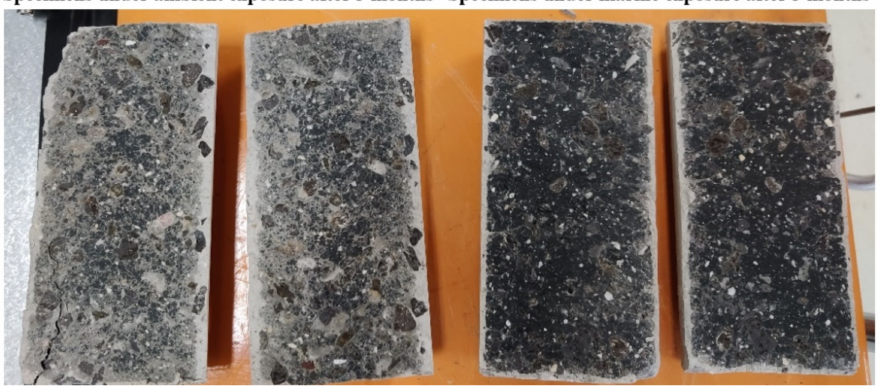
Figure 10. Ambient exposure vs. marine exposure after three